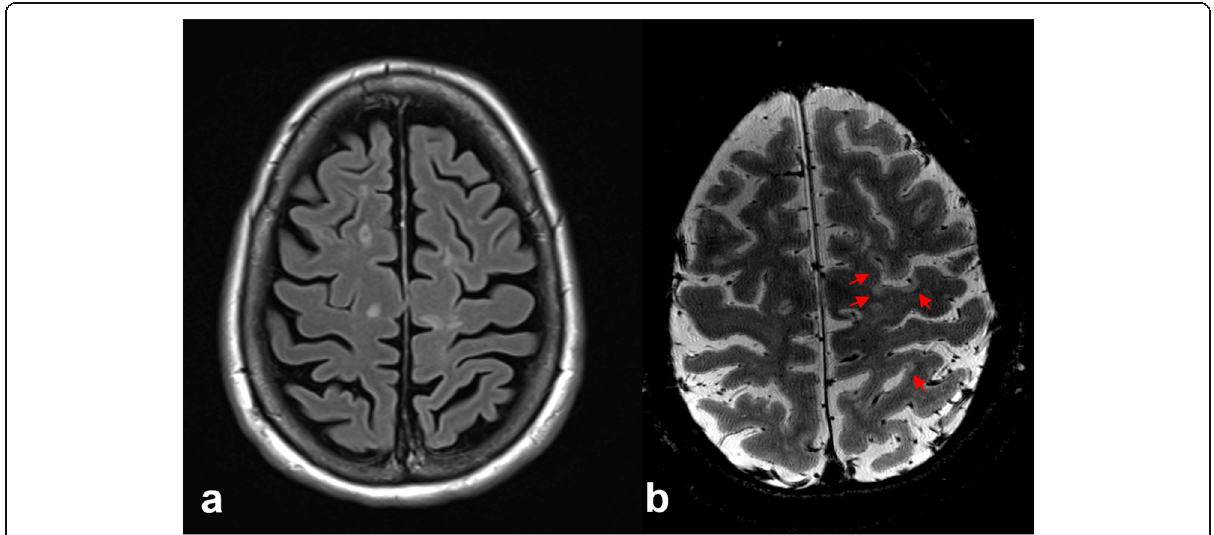
Fig. 5 Cortical lesions in multiple sclerosis on 3-T and 7-T magnetic resonance imaging. Axial fluid-attenuated inversion-recovery (FLAIR) image acquired at 3 T ( a ) and axial T2*-weighted image acquired at 7 T ( b ). The 7-T image shows many more cortical lesions (red arrows), which are not visible on the axial FLAIR ( a ) or T2-weighted image (not shown) at 3 T, due to a combination of increased contrast and spatial resolution at 7